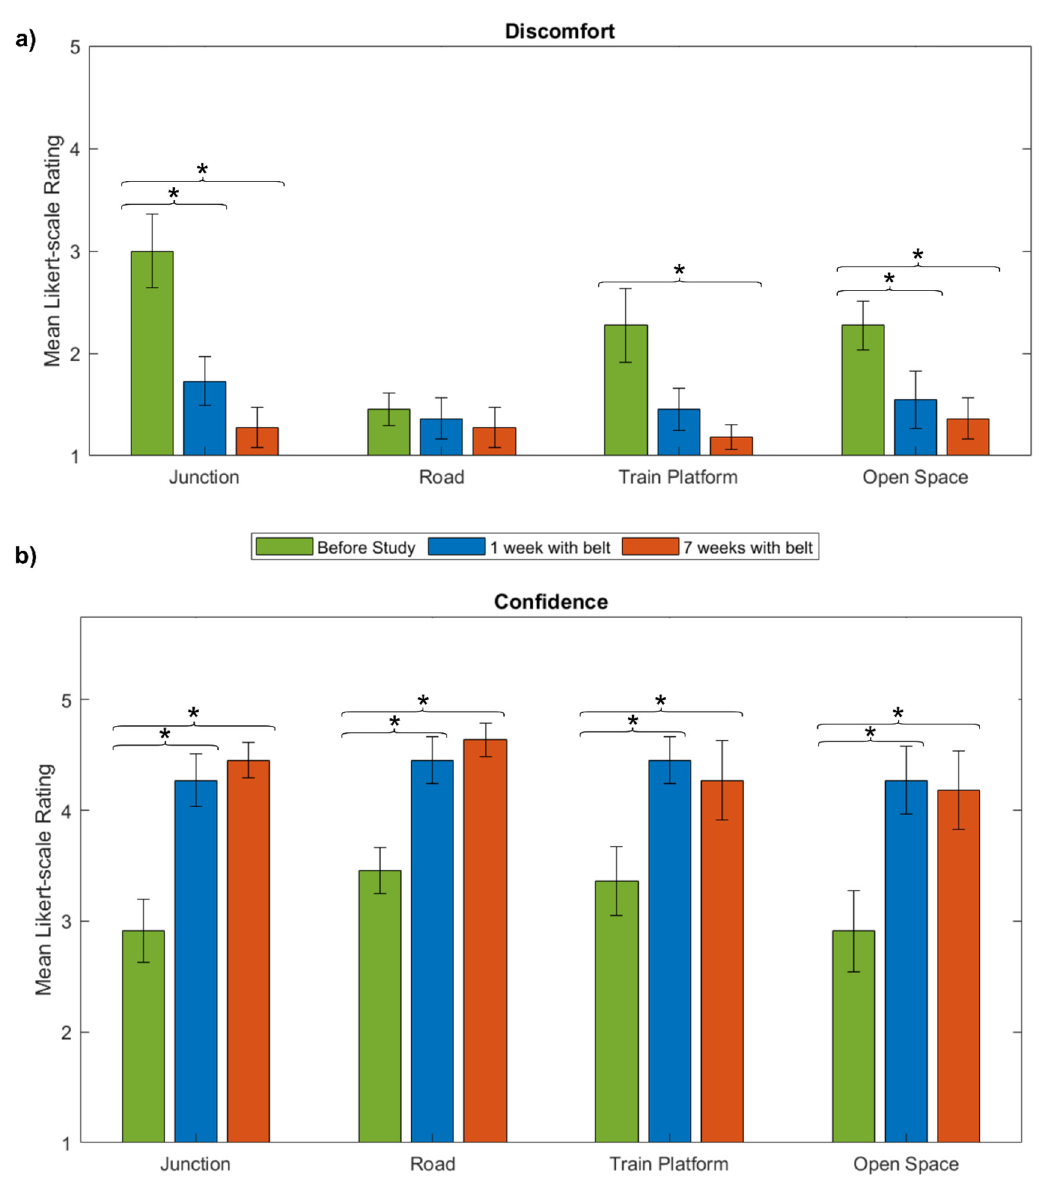
Figure 6. ( a ) The mean Likert scale ratings with the standard error of the mean (SEM) of the self-assessment to what degree the participants felt discomfort when crossing a junction with multiple lanes, crossing a road, walking along a train platform and crossing an open space without any external directional cues before the study (green), after one week with belt (blue) and after seven weeks with the belt (orange) are displayed. ( b ) The mean Likert scale ratings with the SEM of the self-assessment to what degree they felt confident when in the respective situation before the study (green), after one week with belt (blue) and after seven weeks with the belt (orange). The asterisk indicates a significant difference ( p < 0.05).